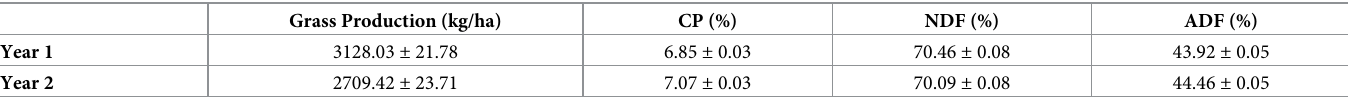
Table 1. Average annual grass production ( ± SE, kg/ha), Crude Protein (CP ± SE; %), Neutral Detergent Fiber (NDF ± SE; %) and Acid Detergent Fiber (ADF ± SE; %) of the experimental paddock for the 2 years of grazing (2016 – 2017, 2017 – 2018) at the Northern Agricultural Research Center Thackeray ranch, Havre, MT. Grass Production